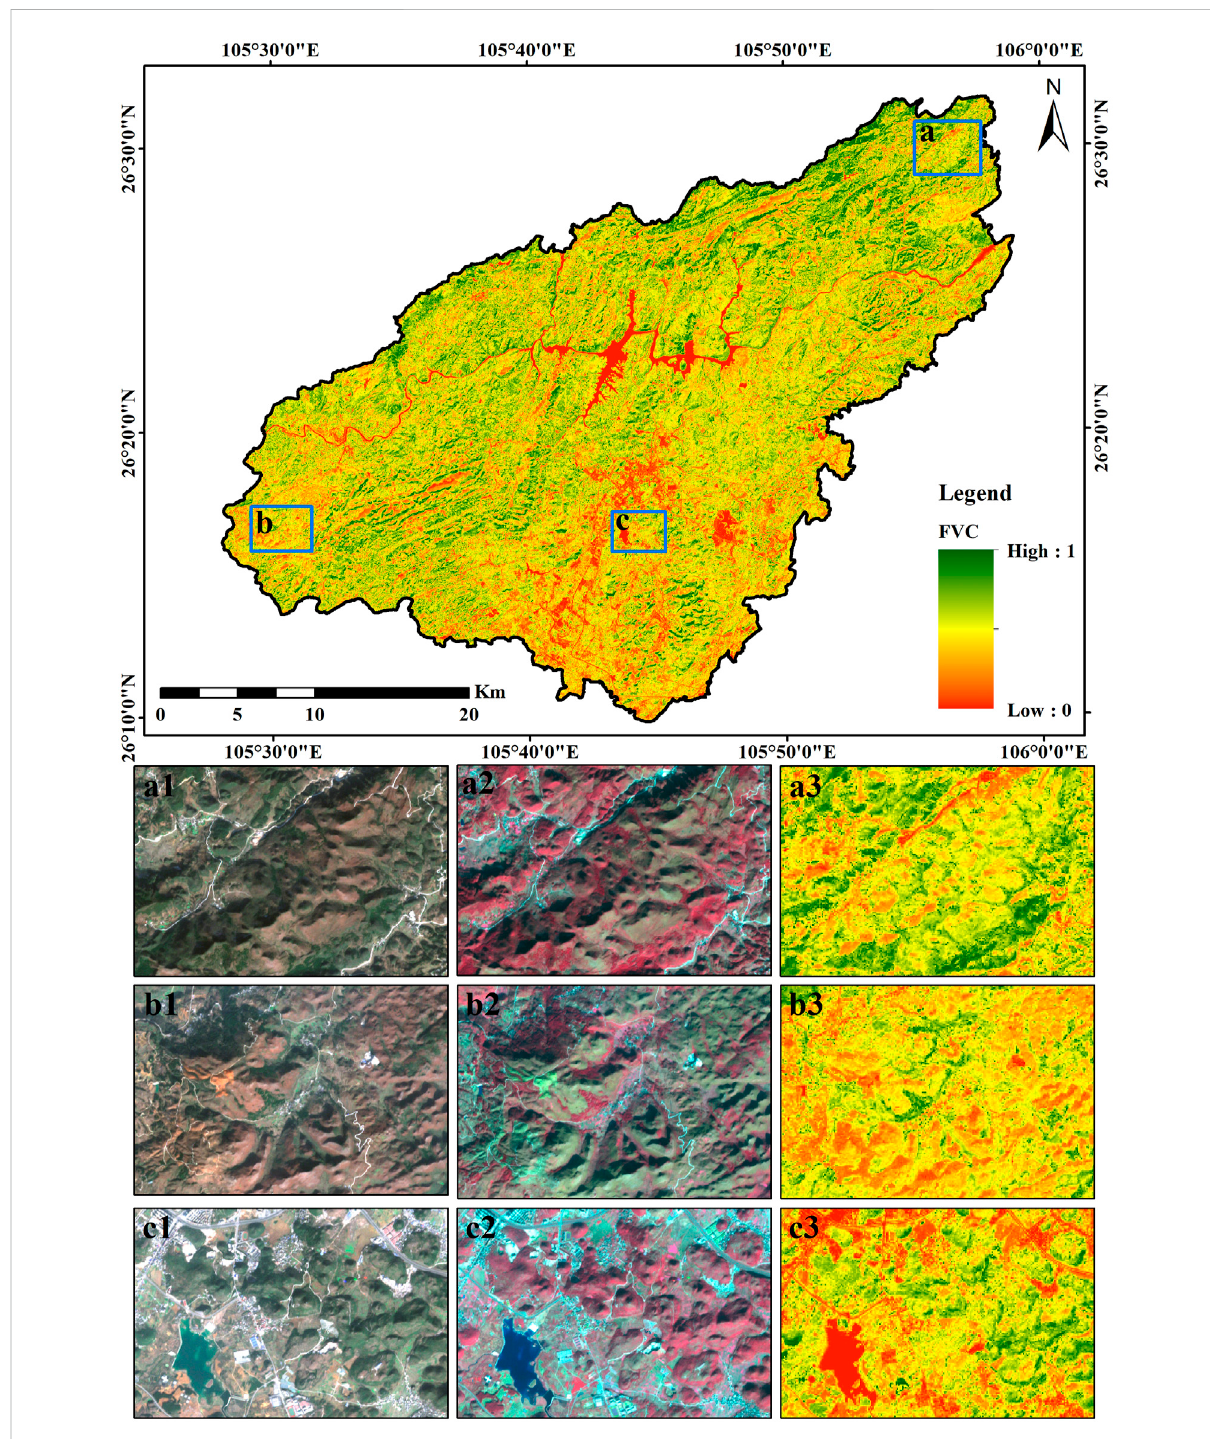
FIGURE 9 Spatial distribution map of f VC based on Sentinel-2. (*1 true-color, *2 stand false-color, *3 f VC